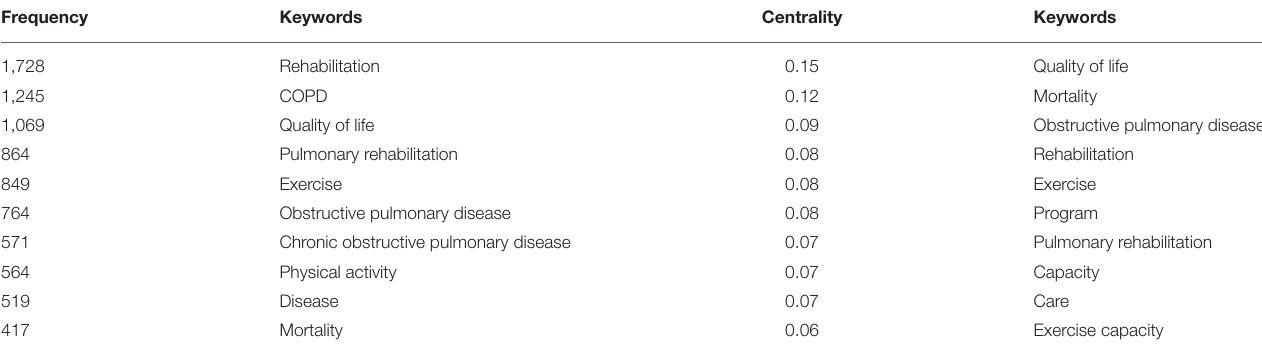
TABLE 6 | Top 10 keywords with frequency and centrality related to pulmonary rehabilitation.